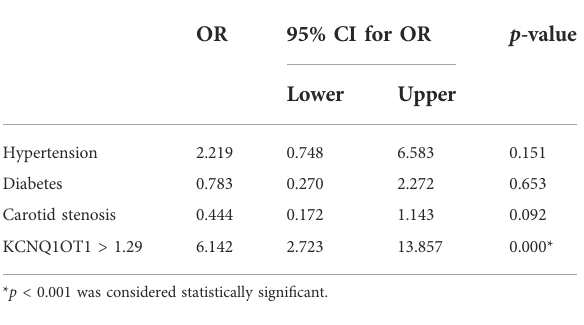
TABLE 3 Expression of KCNQ1OT1 > 1.29 predicts further ischemic stroke.